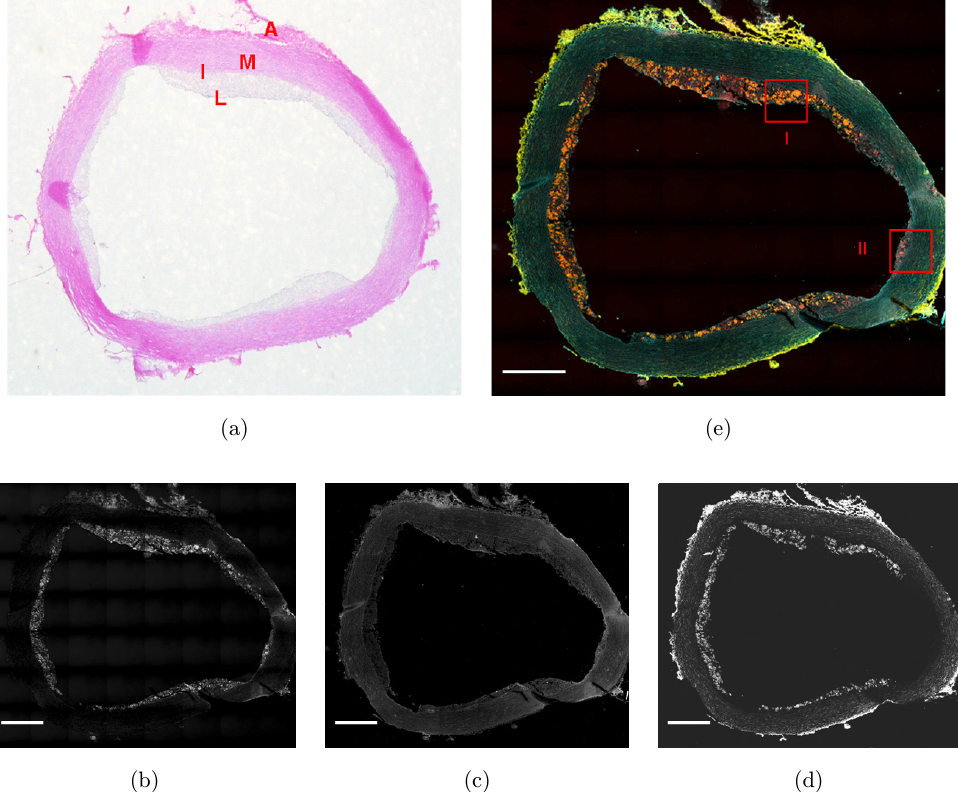
Fig. 1. H&E stained histopathological image of a cross section of a rabbit aorta (a) in comparison with CARS (b), TPF (c) and SHG (d) images acquired from an adjacent section. Clearly noticeable are severe plaque deposits along the intima (I) and the lumen (L). Also visible are the media (M) and adventitia (A). The image shown in (e) is an overlay of the CARS (red), TPF (cyan) and SHG (yellow) signals. The scale bars are 0.5